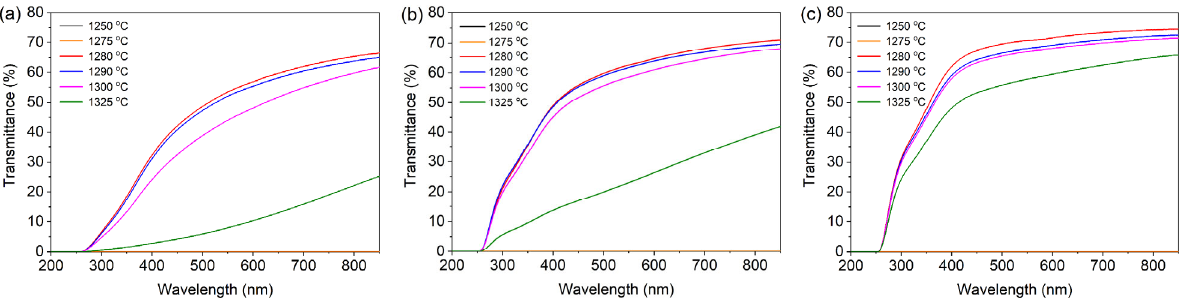
Fig. 6 In-line transmission curves of the 8YSZ ceramics (2.5 mm in thickness) pre-sintered at 1250, 1275, 1280, 1290, 1300, and 1325 ℃ for 4 h and then HIP post-treated at different temperatures for 3 h under 176 MPa in Ar at (a) 1350 ℃ , (b) 1450 ℃ , and (c) 1550 ℃ .